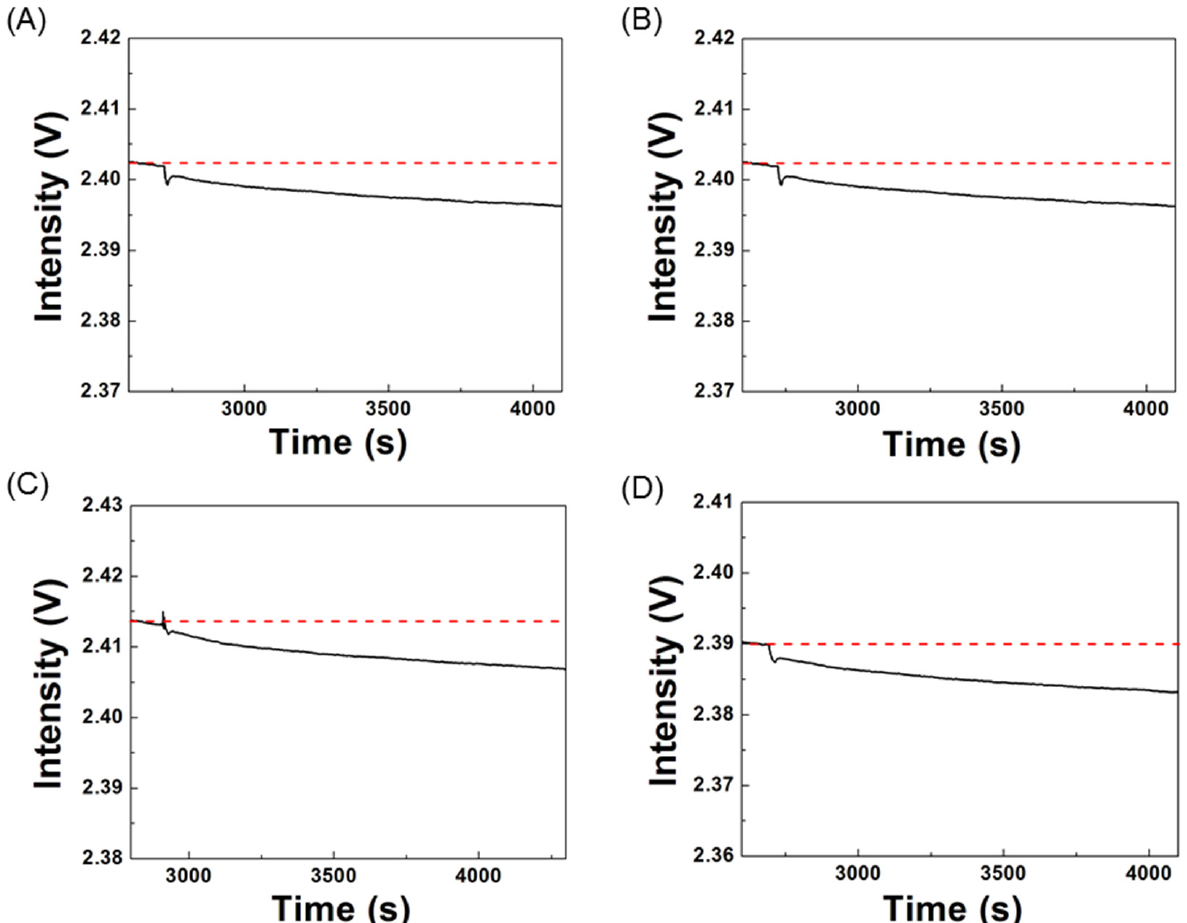
Figure 5. Typical real-time sensorgrams during the bioconjugation process of ssDNA aptamers: ( A ) NP-A48, ( B ) NP-A58, ( C ) NP-A61, and ( D ) NP-A15. Aptamer concentration = 1 µ M. The black solid lines indicate the real-time signals and the red dot lines are tangent lines drawn from the baselines.